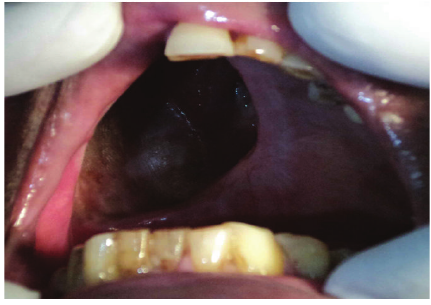
Figure 1: Intraoral view of defect.